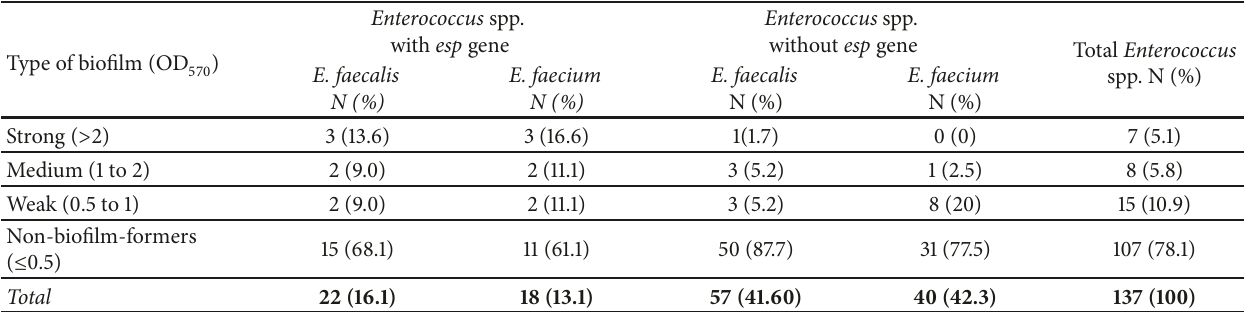
Table 3: Relationship between biofilm and presence of esp gene among Enterococcus spp.